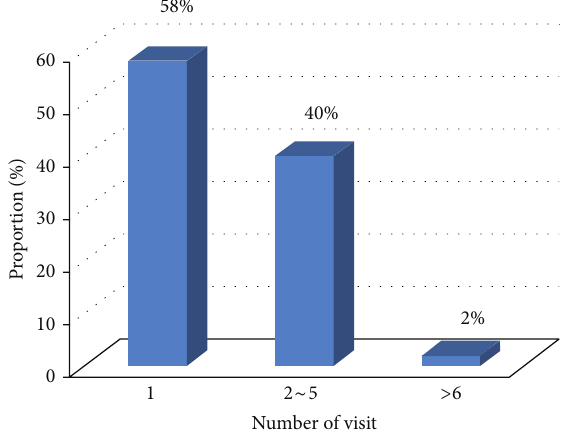
Figure 1: Number visit distribution.